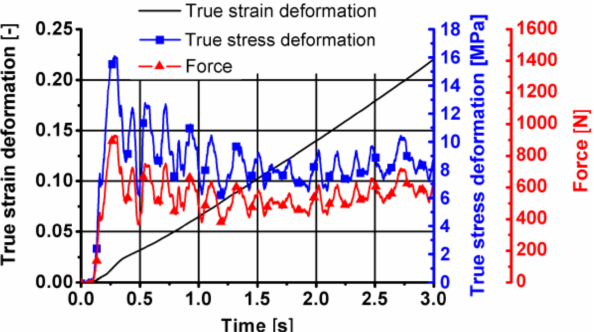
Figure 29. Changes in the true strain deformation, true stress deformation and force over time in the first stage of friction welding of the aluminium 6XXX series—simultaneous torsion with compression components resulting from compression.